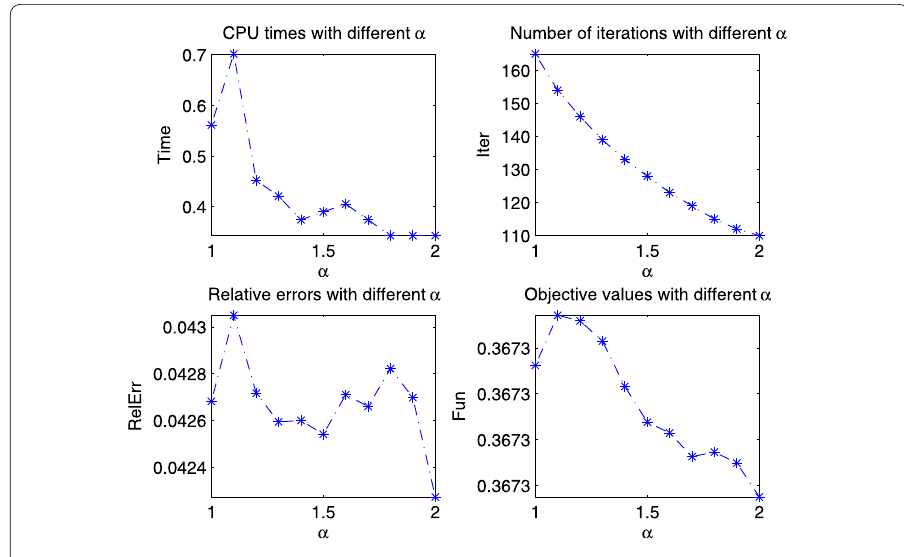
Figure 1 Sensitivity test on the parameter α .